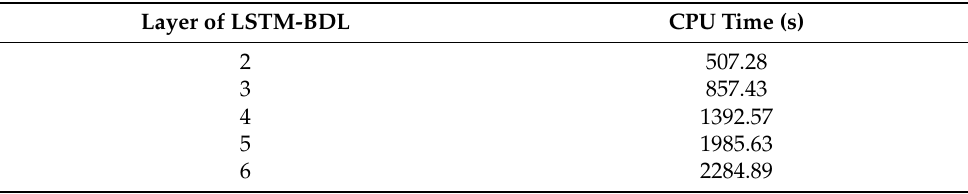
Table 2. Training time for different layers of